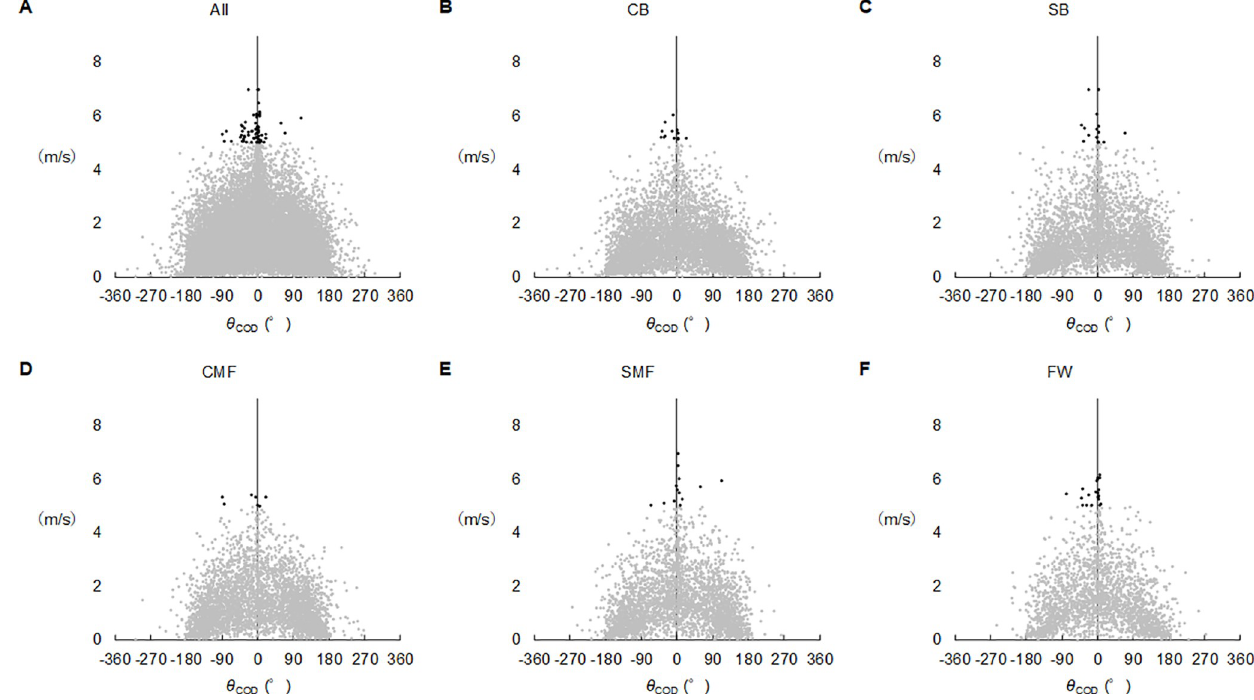
Fig 4. Relationships between θ COD and speed at onset of changing of direction (COD). Black filled circle, the speed of more than 5 m/s; Grey filled circle, the speed below 5 m/s. A: all positions, B: center backs (CB), C: side backs (SB), D: central midfielders (CMF), E: side midfielders (SMF), F: forwards